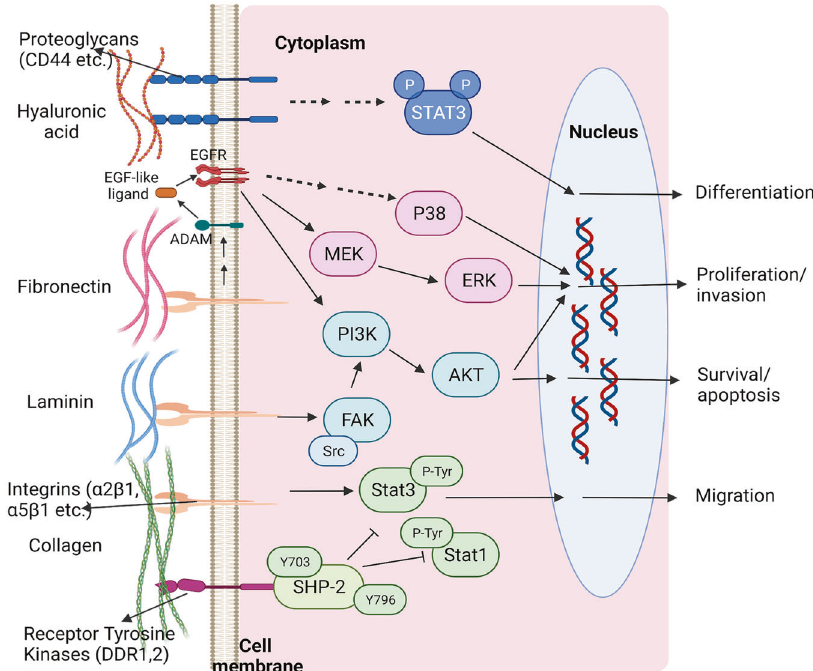
Fig. 8 Different cell attachment site (chemical surface)-induced signaling pathways. Information is collected from published works. 34,279 – 281 The fi gure is made with biorender